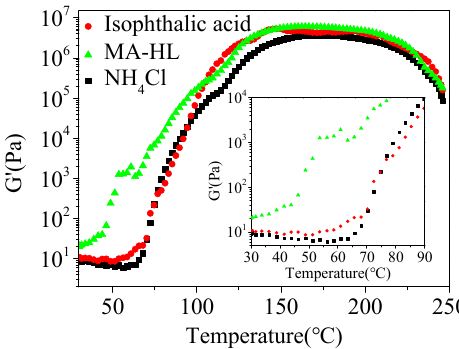
Figure 3. Variable temperature rheology analysis of UF resins with different additives.